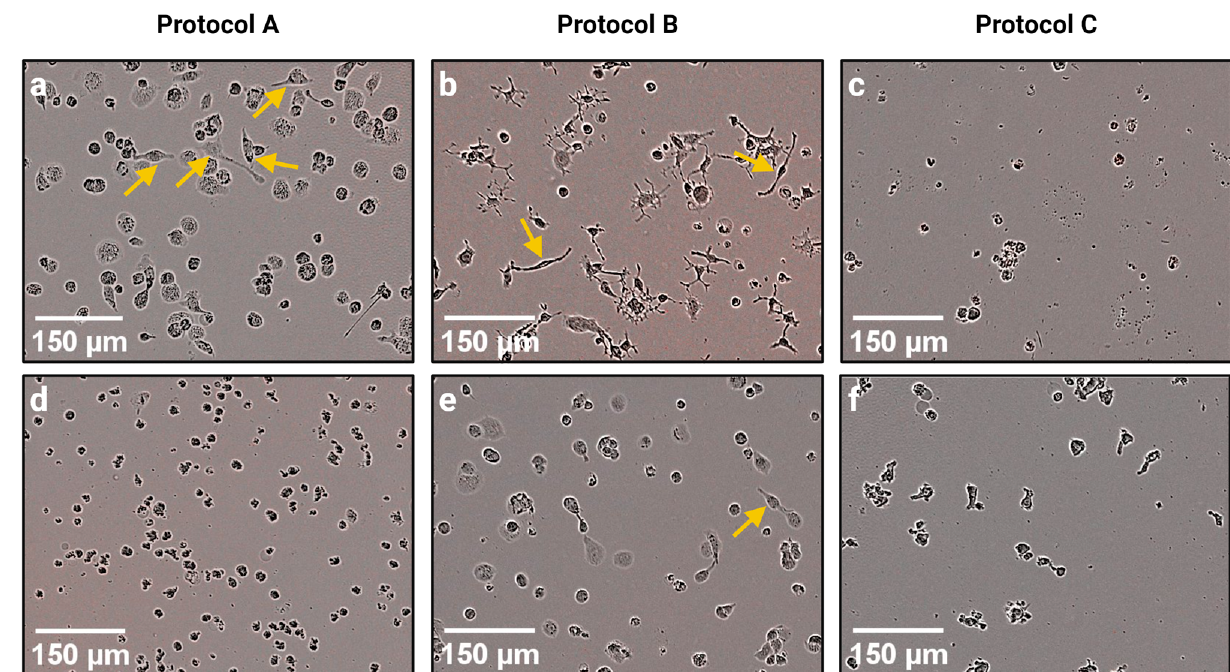
( c ) Figure 3. Morphological analysis of M1_B macrophages. Images were obtained immediately after removing the polarization stimuli for each M φ subset (for time points see Figure 1) by the IncuCyte ® ZOOM reader with 10× objective using the brightfield channel. Morphology of the cell was then outlined and highlighted in BioRender (BioRender, Toronto, ON, Canada). ( a ) Macrophage with spindle-like morphology; ( b ) macrophage with filopodia; ( c ) macrophage with numerous ramified filopodia. Created with BioRender.com; accessed on 7 th December 2022. M1_C and M2_C macrophages had overall a rounded, ragged, or slightly elongated shape (Figure 2c,f).